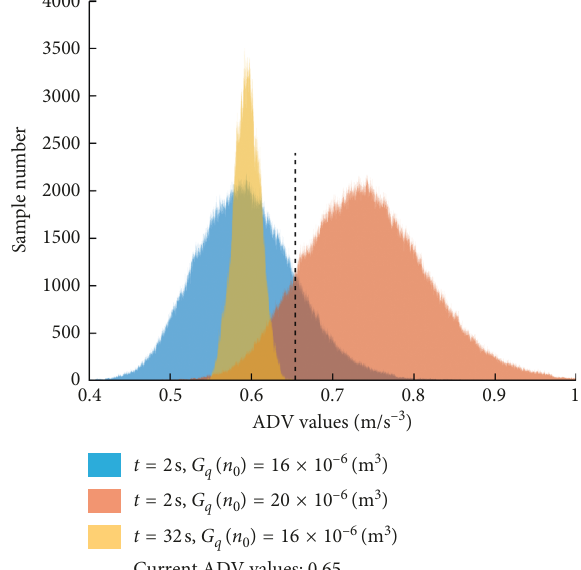
facing with a certain ADV